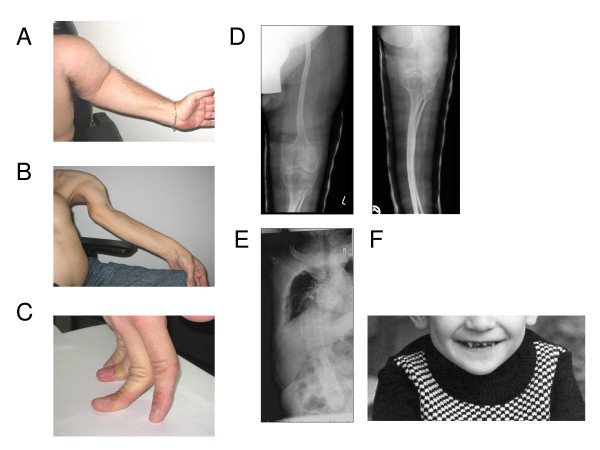
Clinical phenotype. A-B, extended left arm II1, II5. Upper arm is severely shortened in II1 and instabilized by pseudarthrosis in II5. Webbing and contractures are absent; C, joint hypermobility, demonstrated by II4; D, Radiographs of left leg and E, left side of thorax showing severe kyphoscoliosis (II4); F, Dentiogenesis imperfecta (primary teeth) in II5.